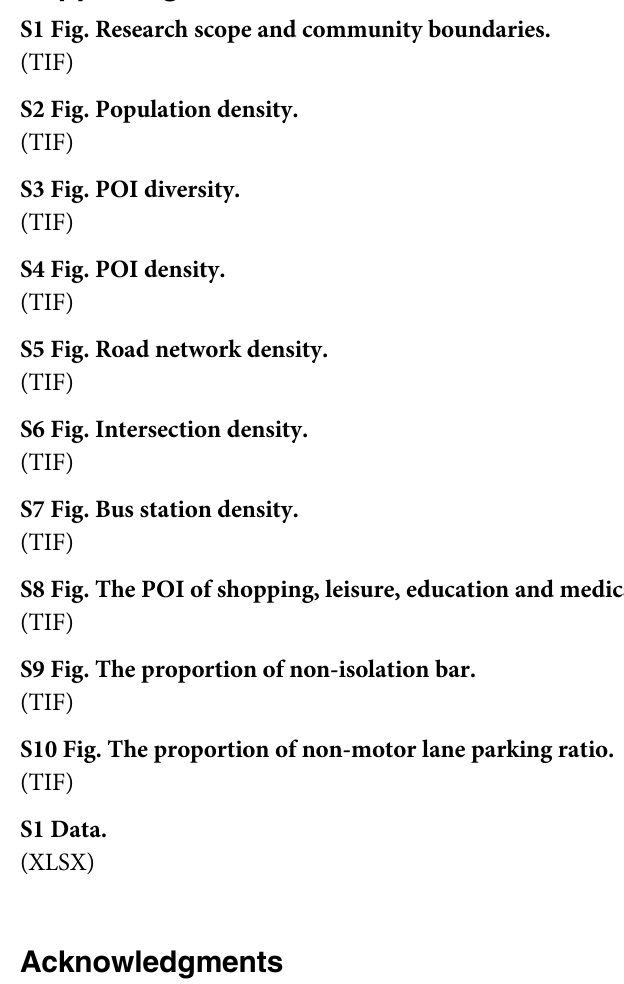
S10 Fig. The proportion of non-motor lane parking